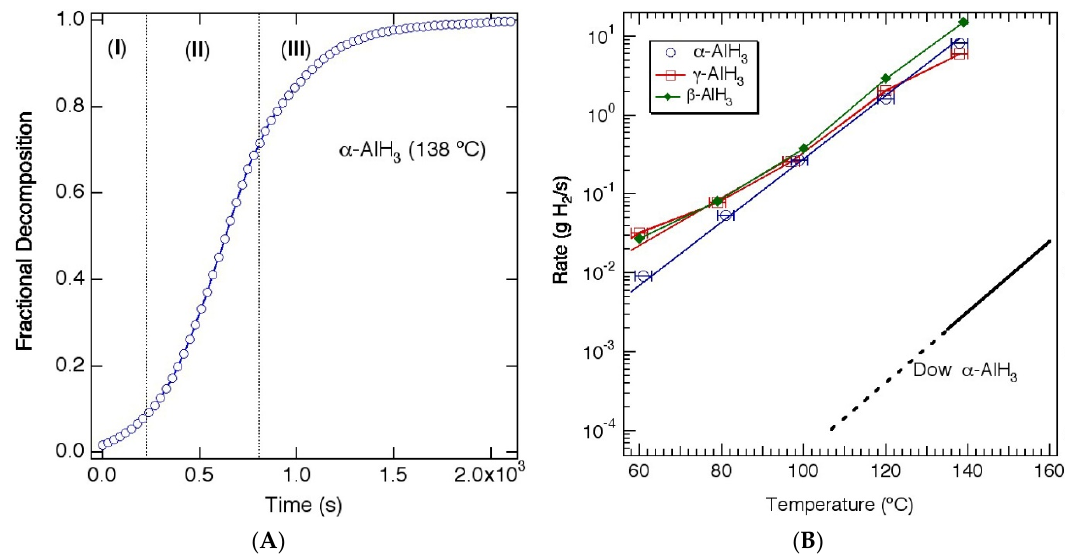
Figure 2. ( A ) Isothermal decomposition of α -AlH 3 (Dow) at 138 ◦ C showing (I) induction period, (II) acceleratory period, and (III) decay period. ( B ) Rate of H 2 release as a function of temperature during thermal decomposition of α , β , and γ -AlH 3 and α -AlH 3 prepared by the Dow Chemical Company. Reproduced from [10]. (Adapted with permission from